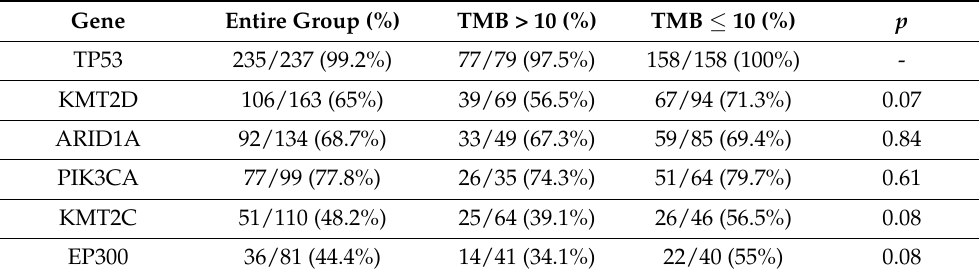
Table 2. Functional significance of commonly mutated genes in urothelial bladder carcinoma in the whole cohort and the groups with high and low TMB. The table shows the number and percentage (in parentheses) of mutations evaluated as likely oncogenic in the OncoKB